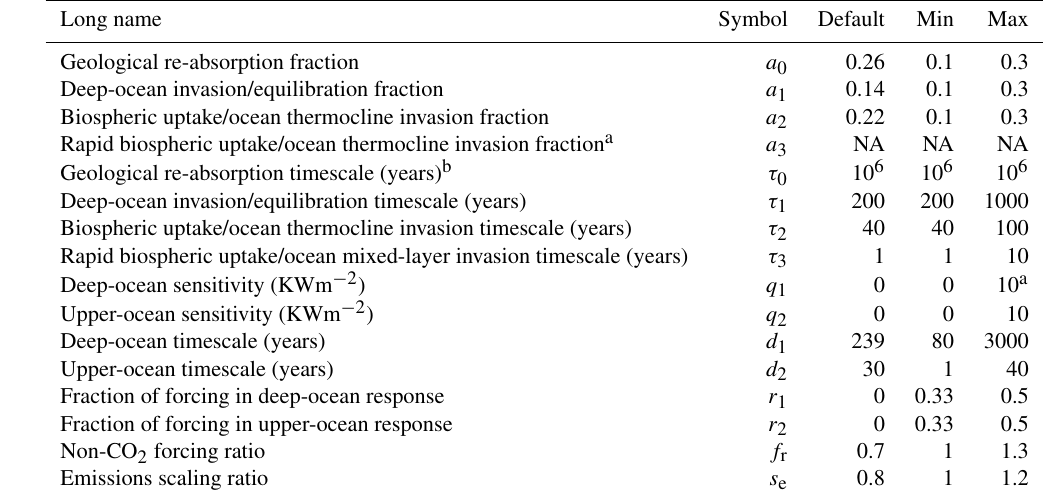
Table 1. A table showing default model parameter values and minimum and maximum values used in model optimization. a a 3 is calculated as the 1 − (cid:80) i = 1 : 3 ( a i ). b Following Millar et al. (2017c), deep-ocean carbon uptake timescale is not included in the optimization (the timescale is effectively infinite: sufficiently longer than the scenarios considered here for the a 3 pool to not absorb significant carbon). NA: not